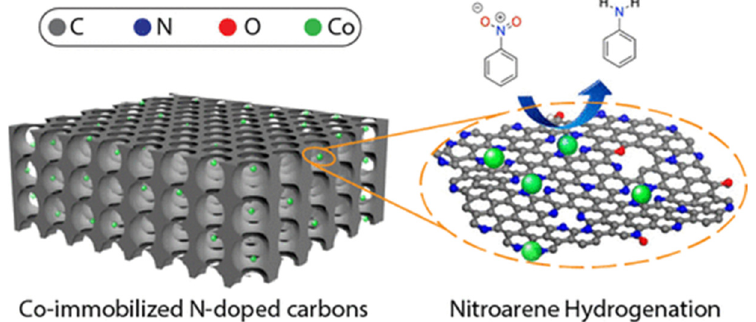
Figure 3. A nitrogen-doped carbon supported cobalt nanoparticle catalyst (CN1meso-Co) for nitrobenzene hydrogenation. Reprinted with permission from Ref. [30]. Copyright © American Chemical Society 2020.